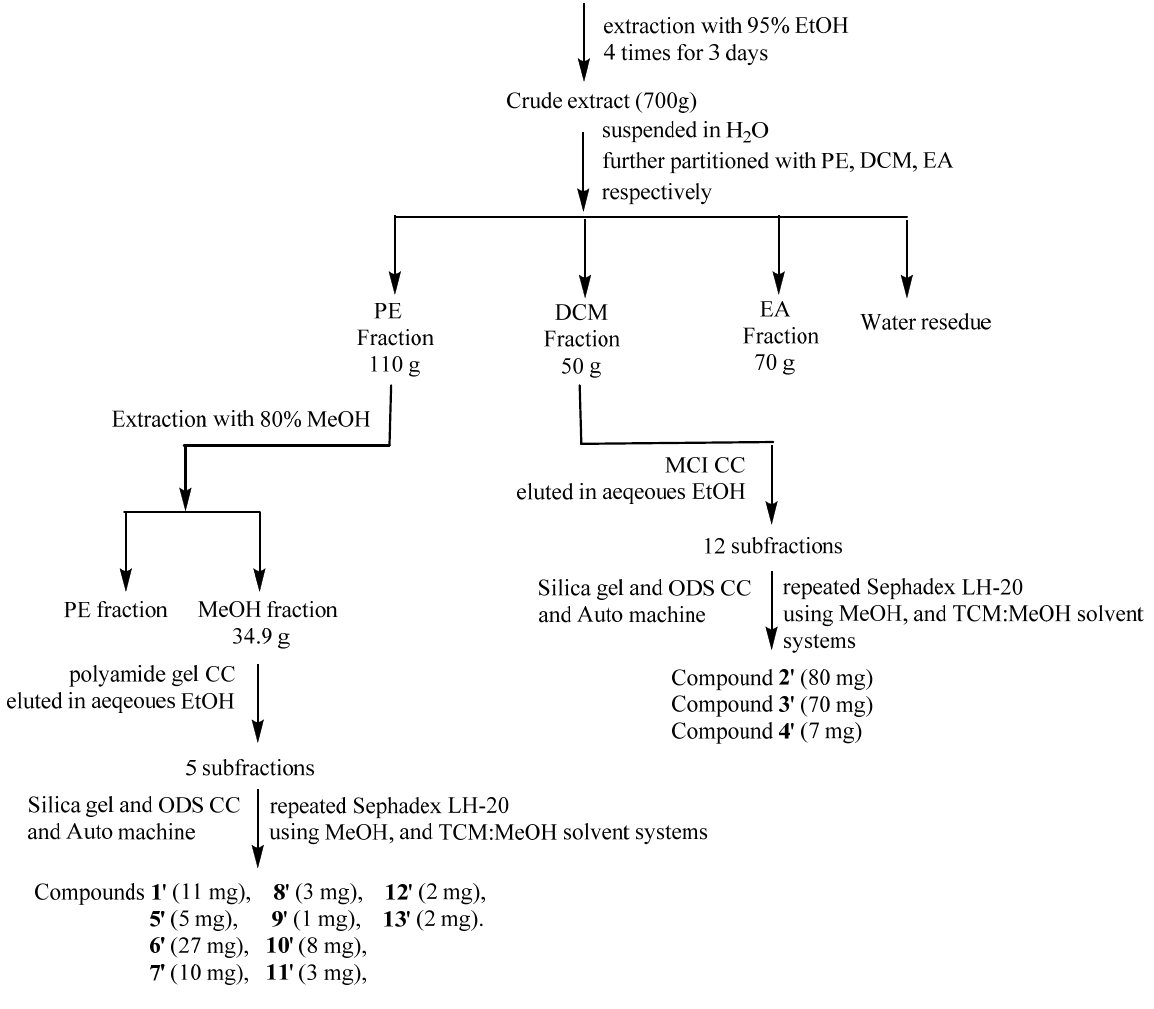
Figure 2. Isolation scheme of A.